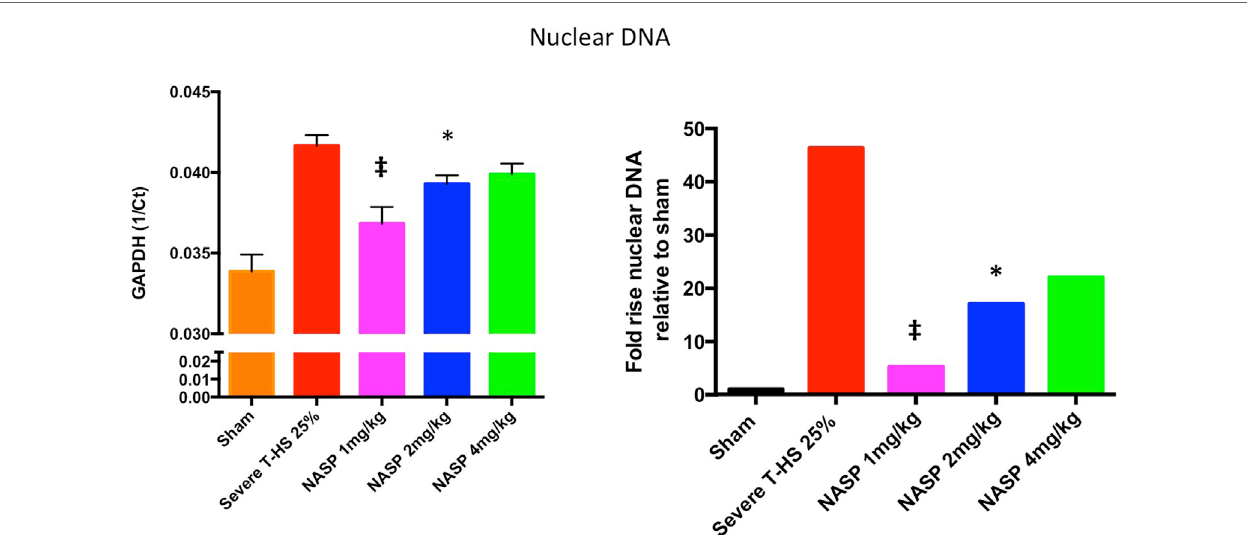
FigUre 5 | A 6-h plasma nuclear DNA concentrations. Cell-free plasma nDNA was measured by real time polymerase chain reaction using GAPDH as the target gene. Y -axis is denoted as the reciprocal of the threshold count, Ct, the PCR cycle at which the rate of PCR product starts to rise exponentially, which corresponds to the amount of starting template. The right hand graph illustrates the corresponding fold increase in nDNA relative to sham. There was a 45-fold increase in nDNA concentration relative to sham, p < 0.0001. Nucleic acid scavenging polymer (NASP) (hexadimethrine bromide) 1 mg/kg resulted in significant attenuation of this rise to fivefold sham levels; ‡ denotes p < 0.001. NASP 2 mg/kg resulted in lesser but significant attenuation to 17-fold sham levels, * denotes p < 0.05. Attenuation with NASP 4 mg/kg was not significant statistically. t -tests used. Mean values with SEM bars shown.